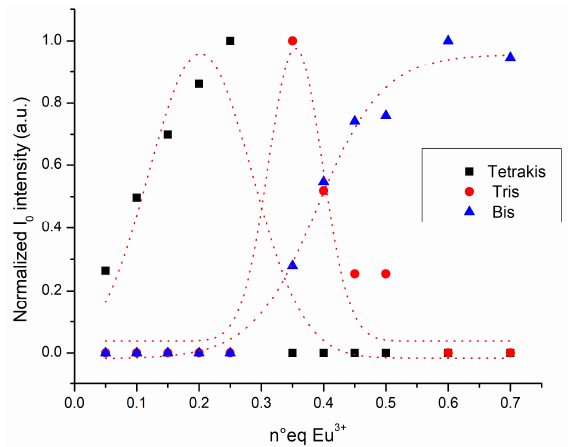
Figure 3. Speciation profile from the isolated contribution of I 0 in the luminescence decay experiment for the Eu 3+ /L 12 − system in water with tendency lines.